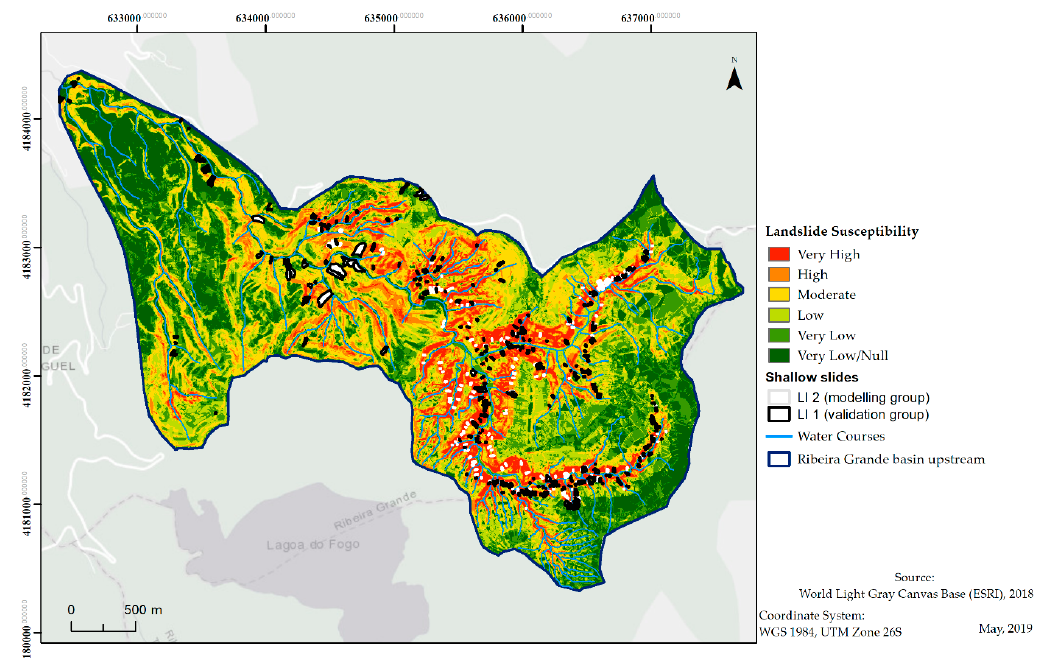
Figure 10. Model B2: Susceptibility to landslides triggered by earthquakes (LI 2) in the upper part of the basin.